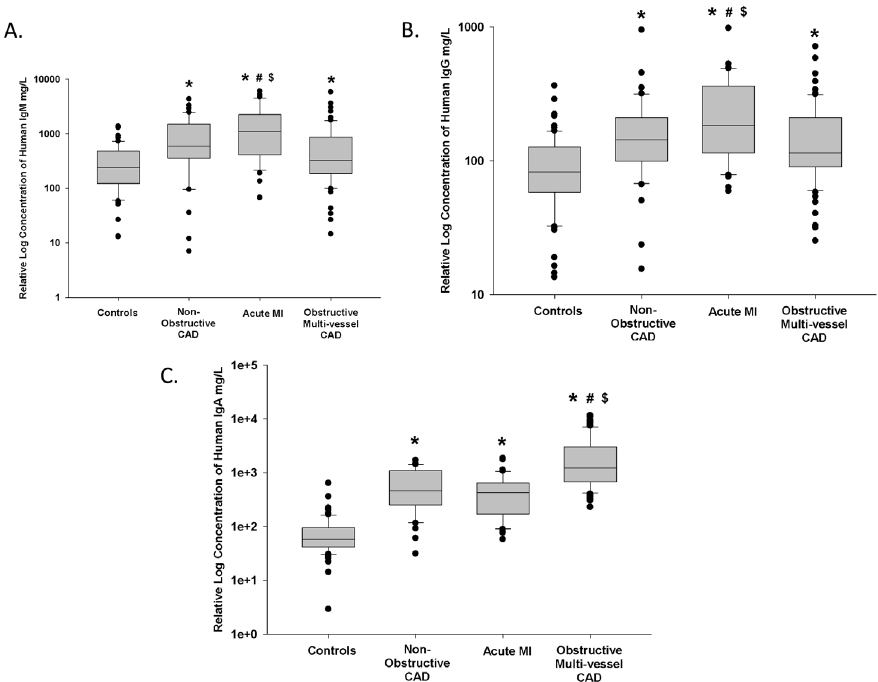
Figure 1. Relative Serum Concentrations of anti-MAA IgM, IgG and IgA Antibodies are Increased in Individuals with Coronary Artery Disease (CAD) and in Individuals who Present with an Acute Myocardial Infarction (AMI). CAD patients were grouped in the following categories; control patients (n=82), patients with chest pain and CAD (Non-Obstructive CAD, n=40), patients presenting with AMI (n=42), and patients with significant Multi-Vessel Obstructive CAD requiring coronary bypass grafting (n=72). Serum anti-MAA antibodies were evaluated for the isotypes IgM (Figure 1A), IgG (Figure 1B), and IgA (Figure 1C). *P , 0.001 significantly increased compared to controls. # P , 0.03 significantly increased compared to Non-Obstructive CAD. $P , 0.003 significantly increased compared to Multi-Vessel Obstructive CAD.